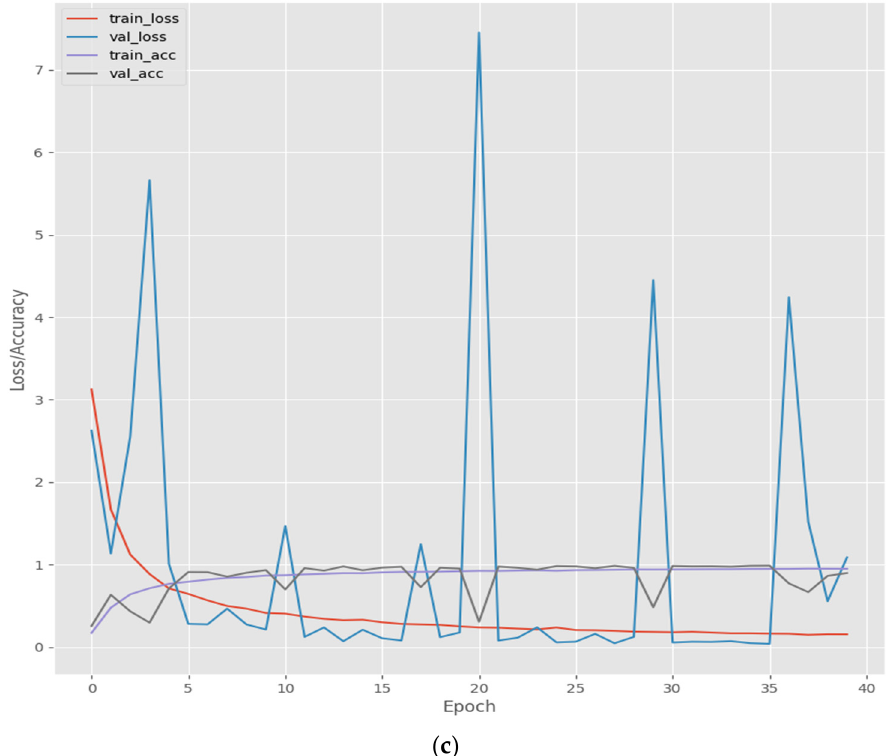
Figure 9. Analysis of the proposed model at 40 epochs and a batch size of 20: ( a ) precision, recall and F1 score for the 24 classes; ( b ) confusion matrix; ( c ) accuracy and loss curve.